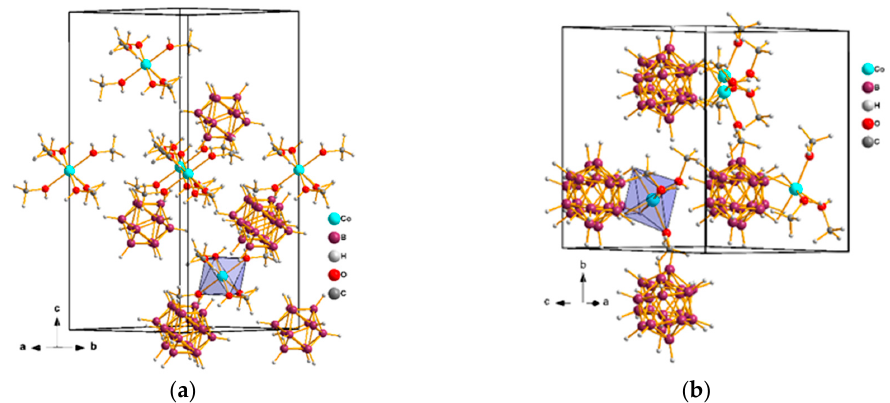
Figure 10. ( a ) View of the Co coordination octahedron inside an octahedron (B 12 H 12 ) 6 of ccp anion packing as observed in r -M(MeOH) 6 (B 12 H 12 ) (M = Fe, Co, Ni, Mg). ( b ) View of the Co coordination octahedron inside an irregular rhombic-prism (B 12 H 12 ) 8 as observed in m -M(MeOH) 3 (B 12 H 12 ) (M = Fe, Co, Ni, Mg). Both optimized by DFT.